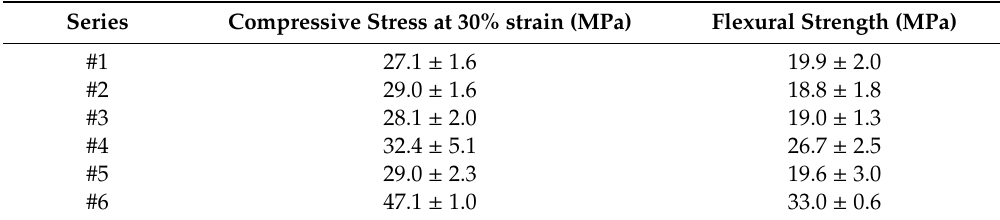
Table 8. Summary of the mechanical test results of the tested composites under compressive and flexural